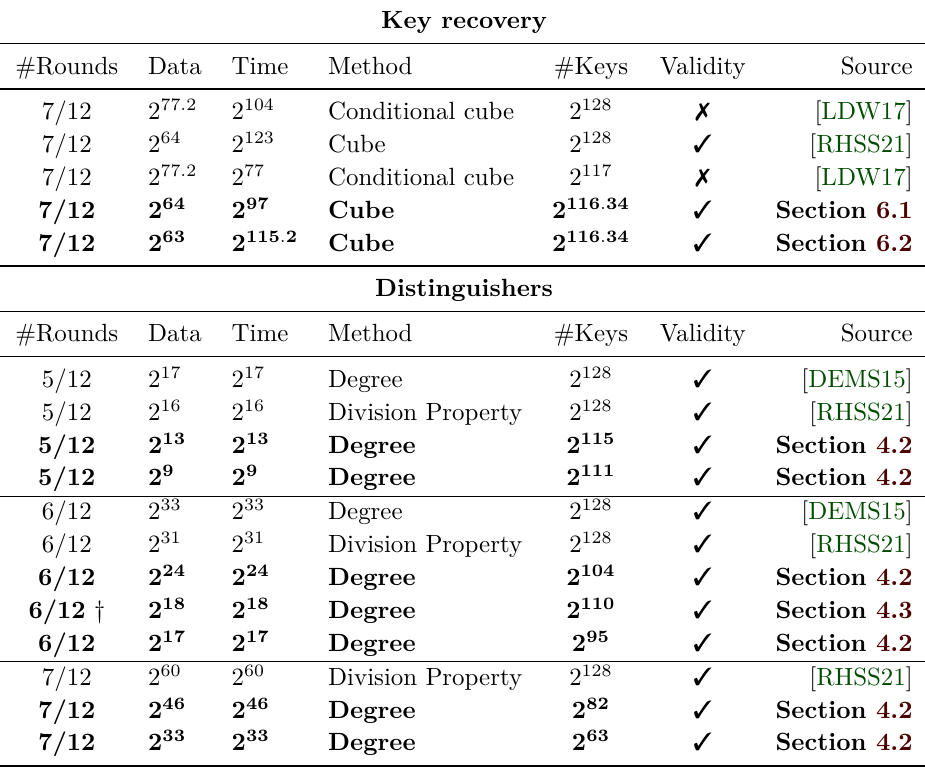
Table 1: Summary of attacks on Ascon in the nonce-respecting setting Key